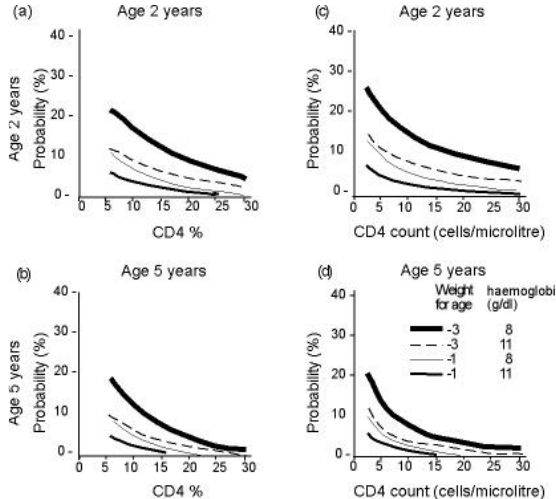
Fig. 3. Estimated risk of death within 12 months for a child on co-trimoxazole prophylaxis by age, weight-for-age z- score and haemoglobin and CD4 percentage or count. (a) CD4% at 2 years of age; (b) CD4% at 5 years of age; (c) CD4 count at 2 years of age; and (d) CD4 count at 5 years of age (reproduced with permission from AIDS 18